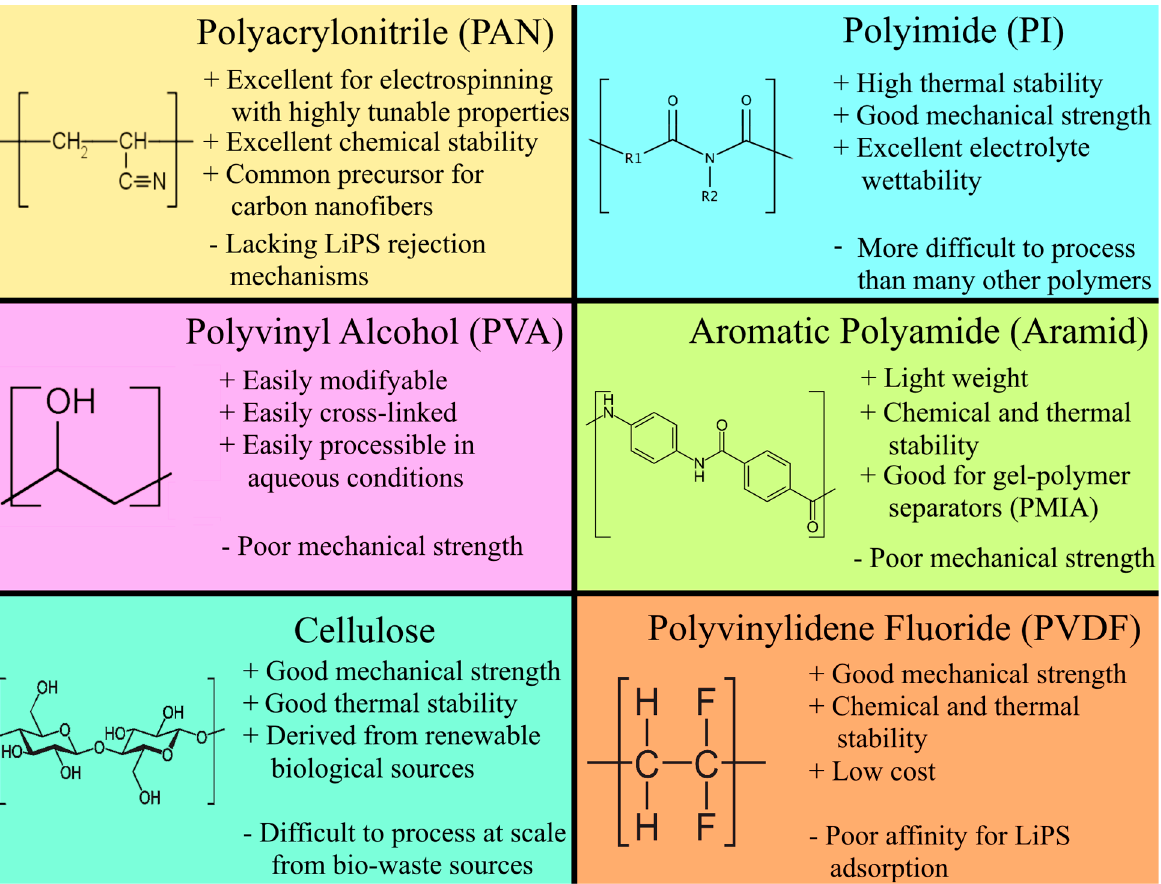
Figure 4. The advantages and disadvantages of promising polymer materials for NF separator fabrication and application in LSBs.